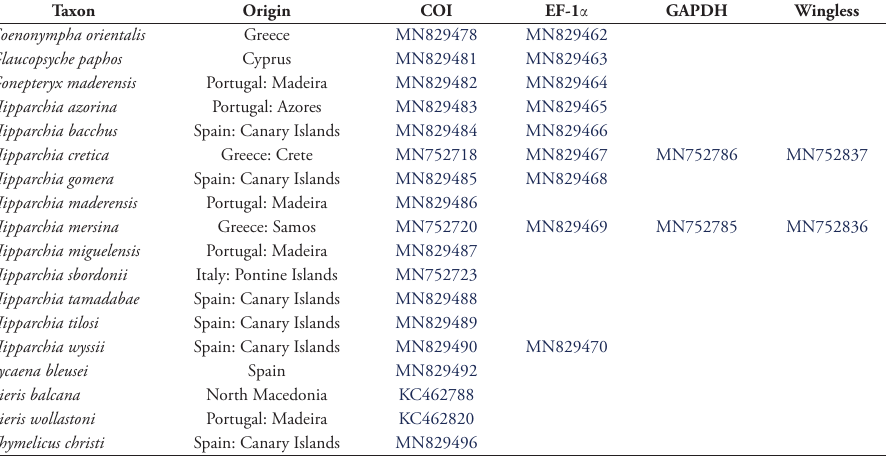
table 1. Newly sequenced species for which no published sequences had previously been available.